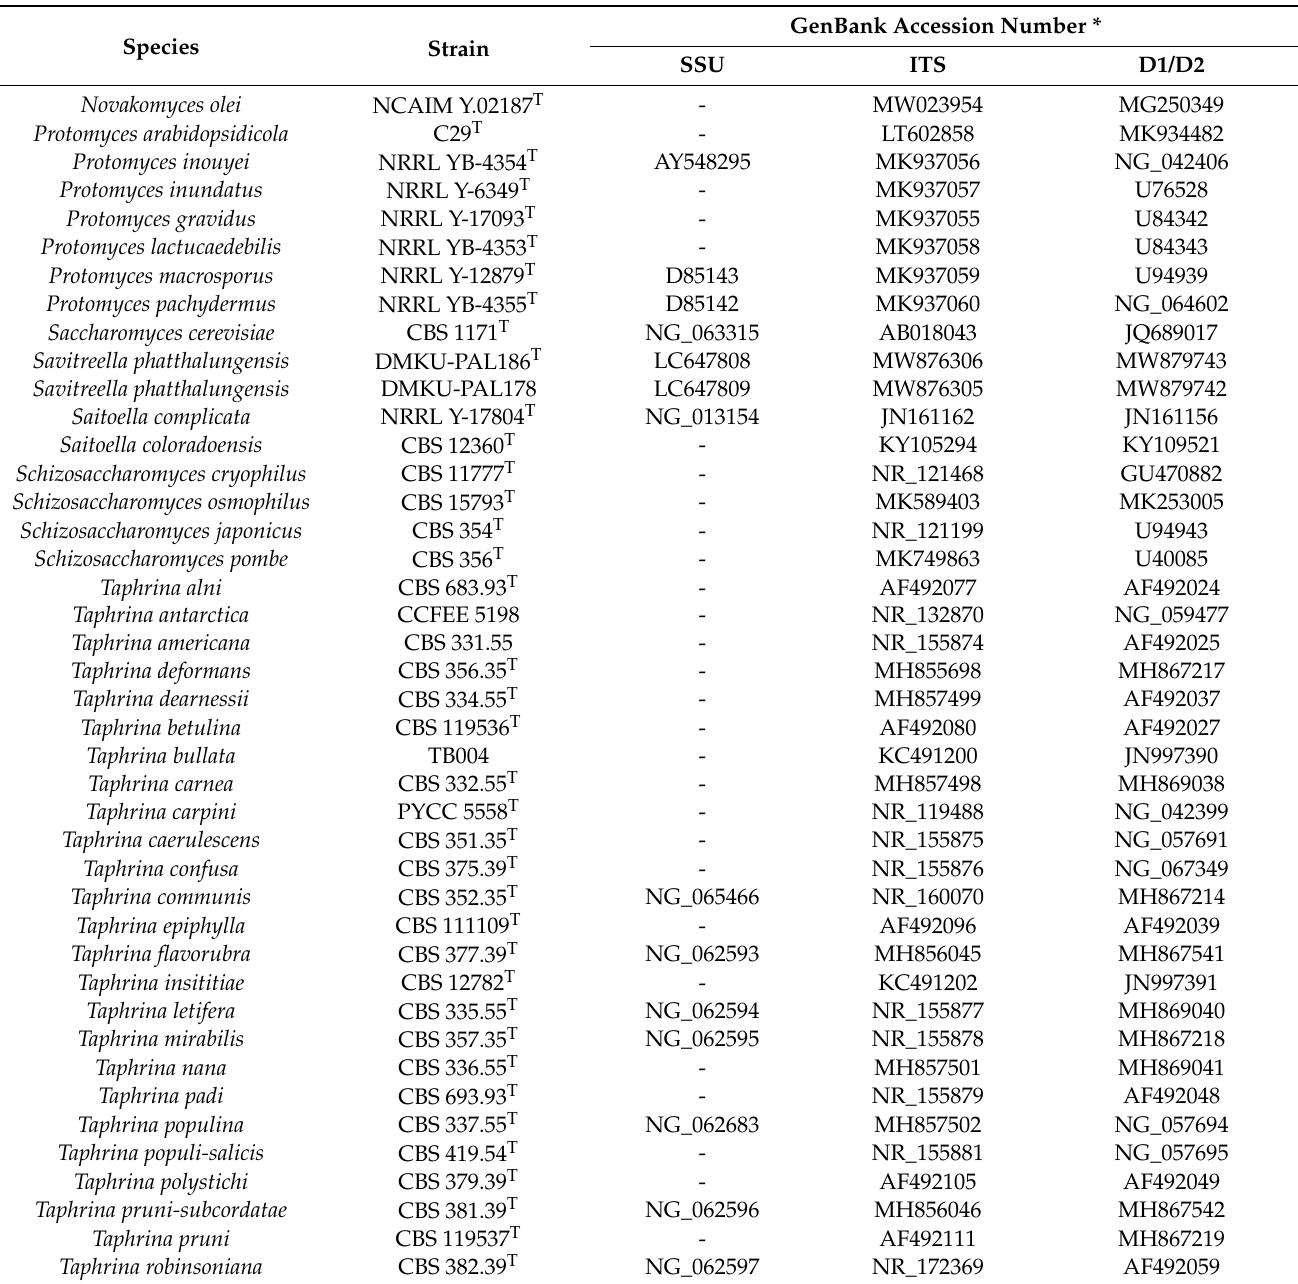
Table 1. Sequences of the representative species in the Taphrinomycotina (Ascomycota) used in the phylogenetic